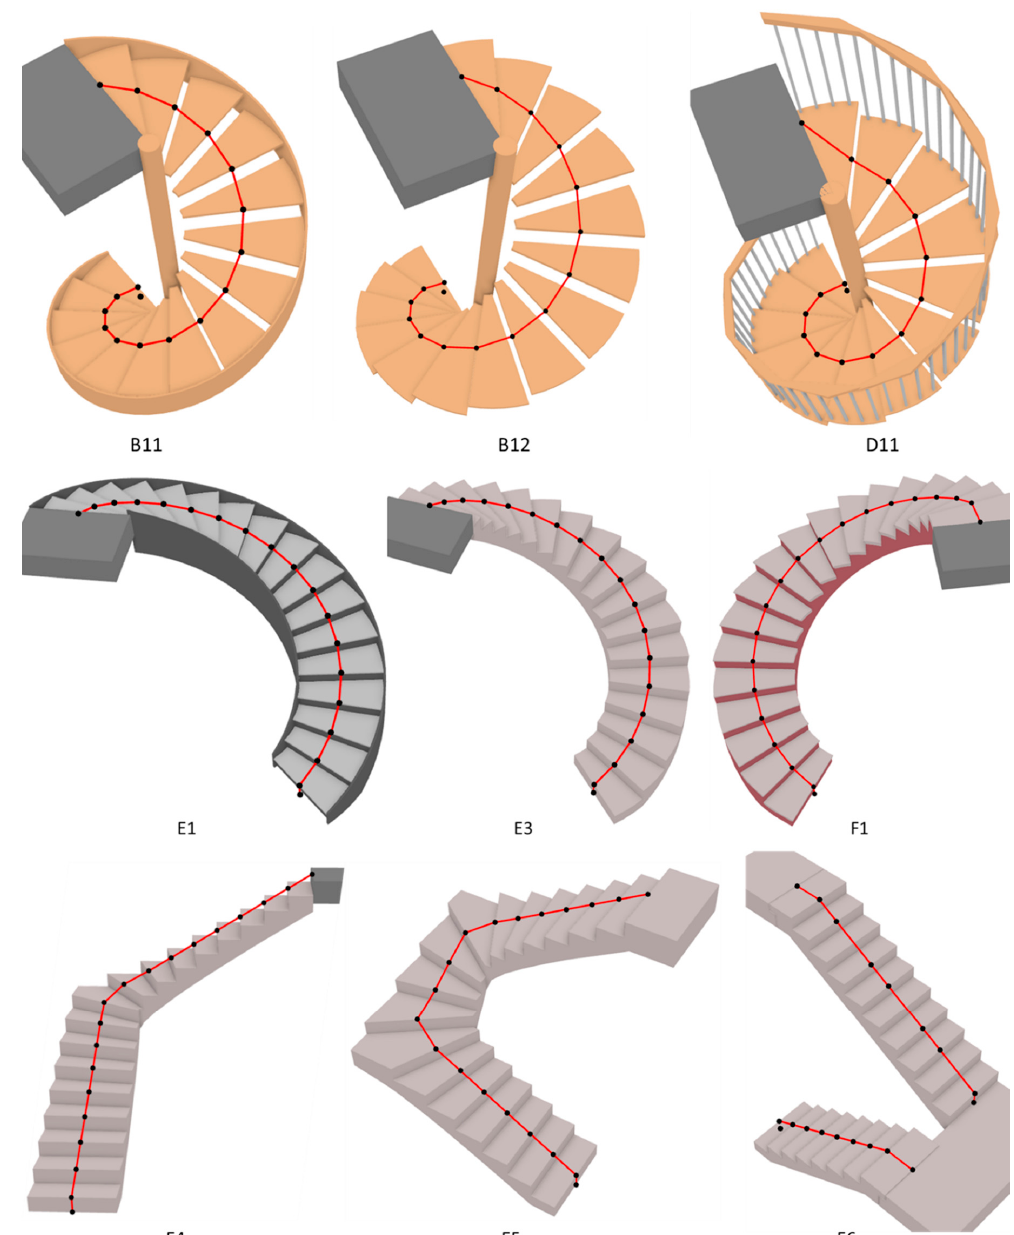
Figure 20. The test results for Groups 7–13.